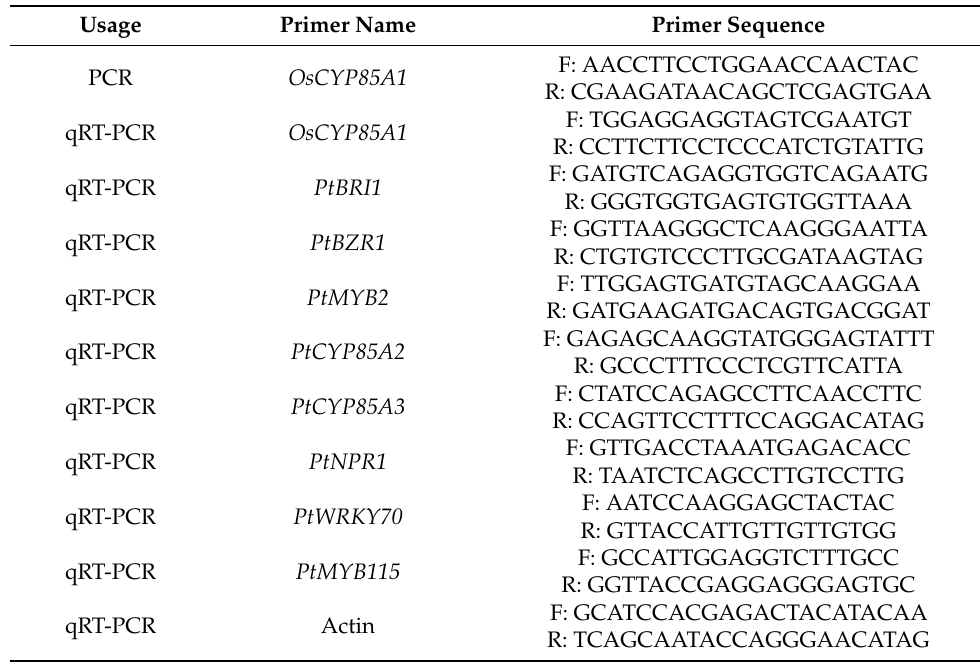
Table 1. List of primers used in this